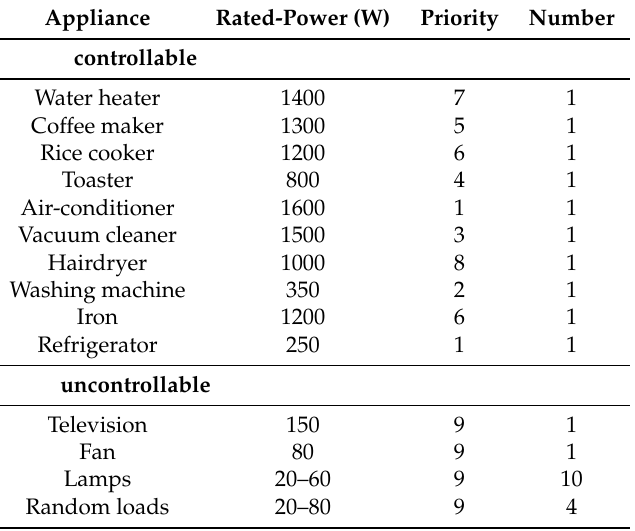
Table 1. Type and priority along with rated power of the house